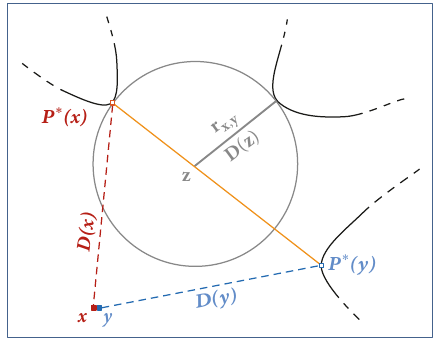
Figure 1: Illustrative representation of the concepts involved in DMA